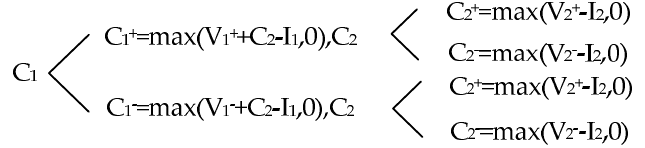
Figure 6. The binomial lattice of real options value.